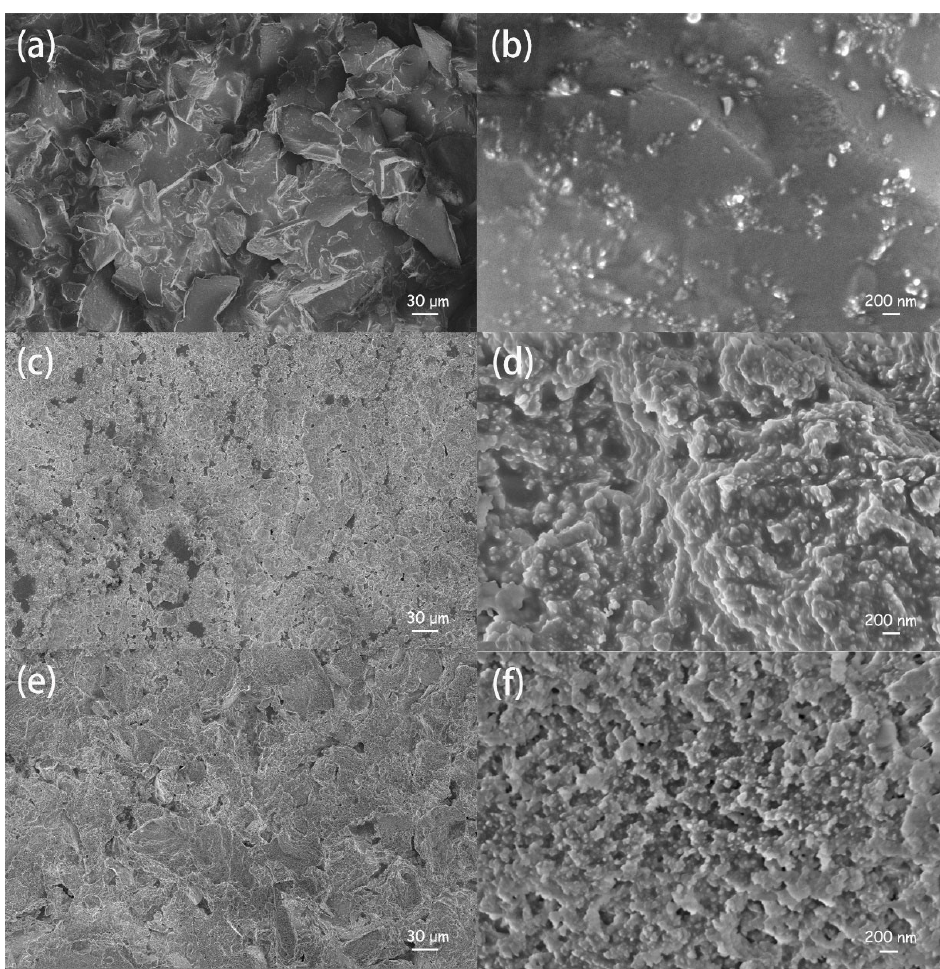
Figure 2. ( a , b ) SEM image of coating A. ( c , d ) SEM image of coating B. ( e , f ) SEM image of coating C.